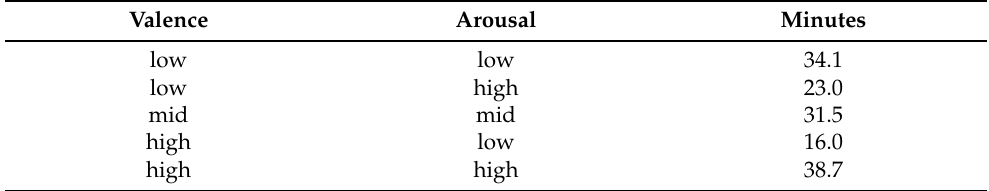
Table 1. Total duration of all of the stimuli for each Arousal-Valence category